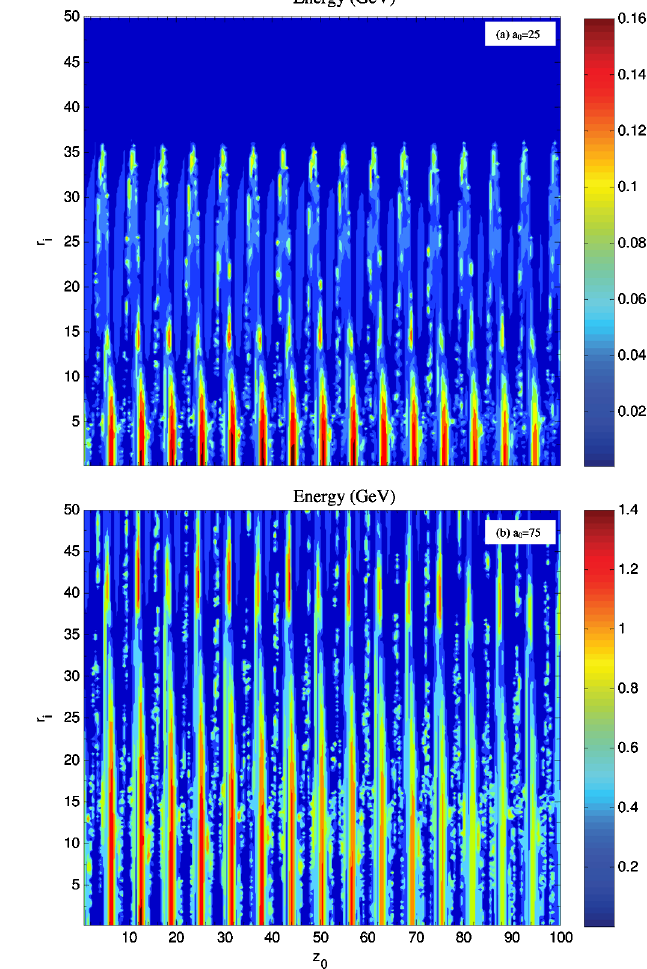
FIG. 7. Electron energy (in GeV) distribution as a function of normalized t 0 and z L for (a) a 0 ¼ 25 , and (b) a 0 ¼ 75 . Other parameters are r i ¼ 0 , r 0 ¼ a 0 , (cid:3) ¼ 200 , ’ 0 ¼ (cid:2) , and 0 . z 0 ¼